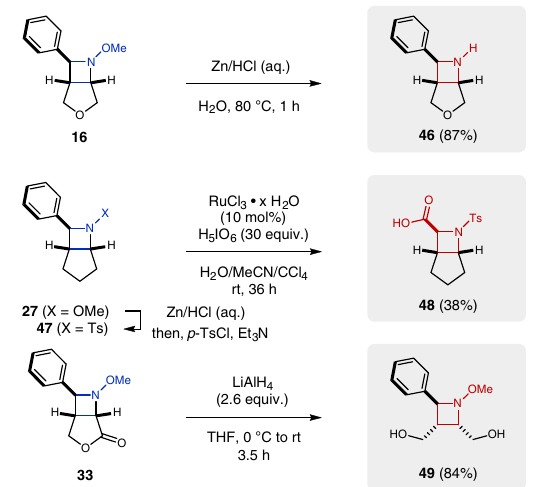
Fig. 6 Synthetic modi fi cations of azetidine products. The accessed azetidines can be converted to the corresponding unprotected azetidine ( 46 ), azetidine-2-carboxylic acid ( 48 ), or monocyclic azetidine ( 49 ) C – C bond formation to result in a 1,4-biradical (intermediate II). This intermediate allows for free rotation around the C – N bond after ring-opening (intermediate I) and relaxation back to the ground state. Alternatively, intermediate II can undergo NATURE COMMUNICATIONS| (2019) 10:5095